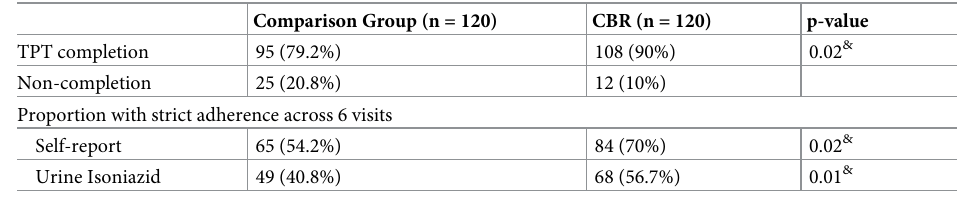
Table 2. TPT completion &